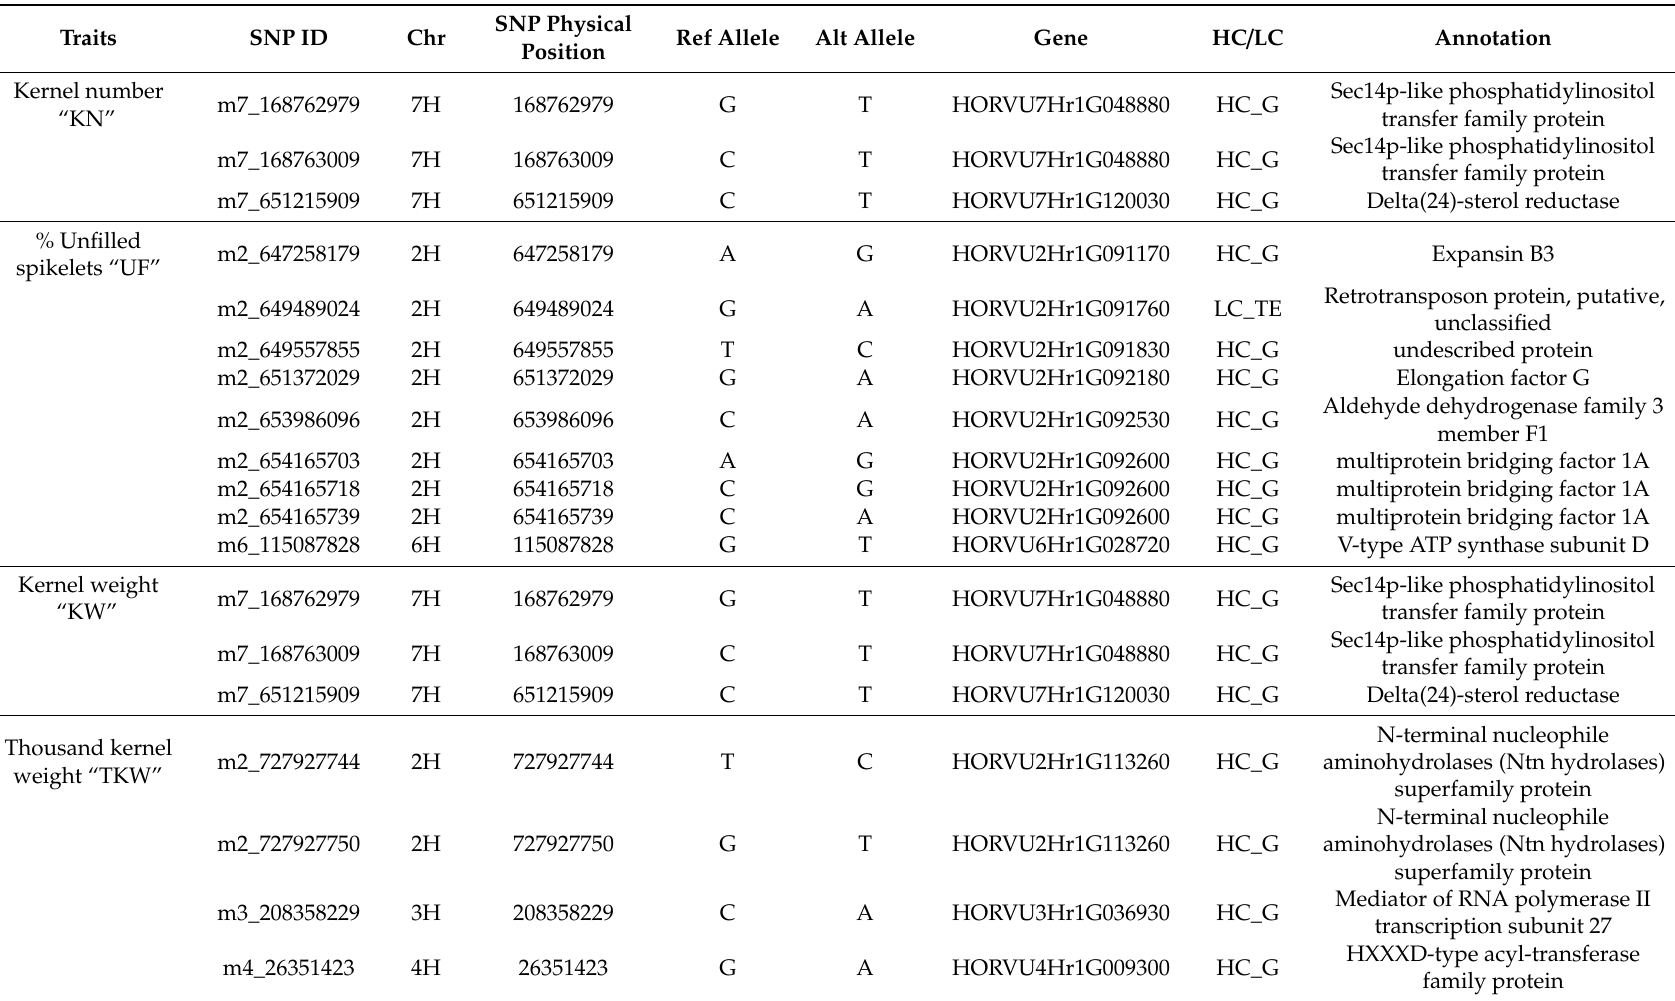
Table 2. Significant SNPs showing the highest marker-trait associations for the lateral